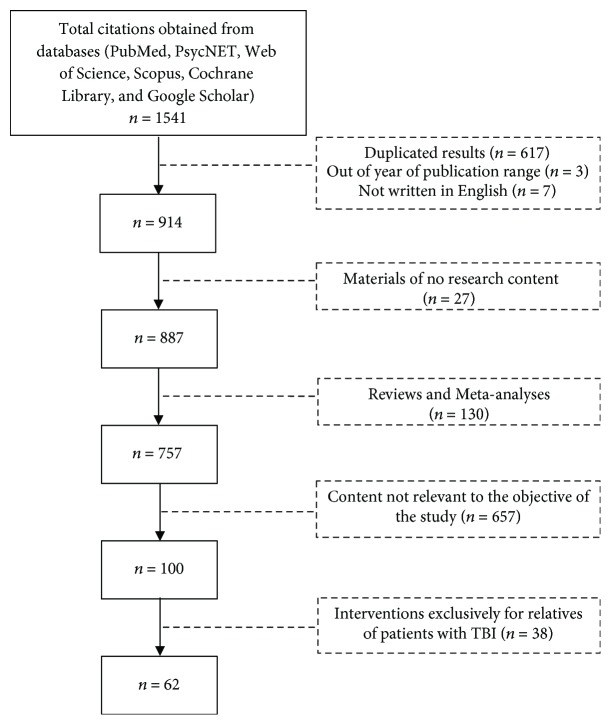
Study flow diagram.